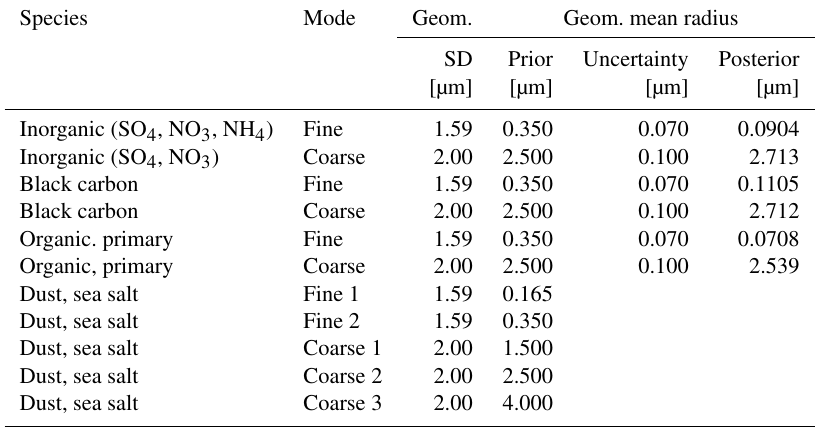
Table 4. Geometric means and standard deviations used for aerosol radius size distributions in this study. The columns for (prior) uncertainty and posterior geometric mean are used as input and obtained as output of the assimilation